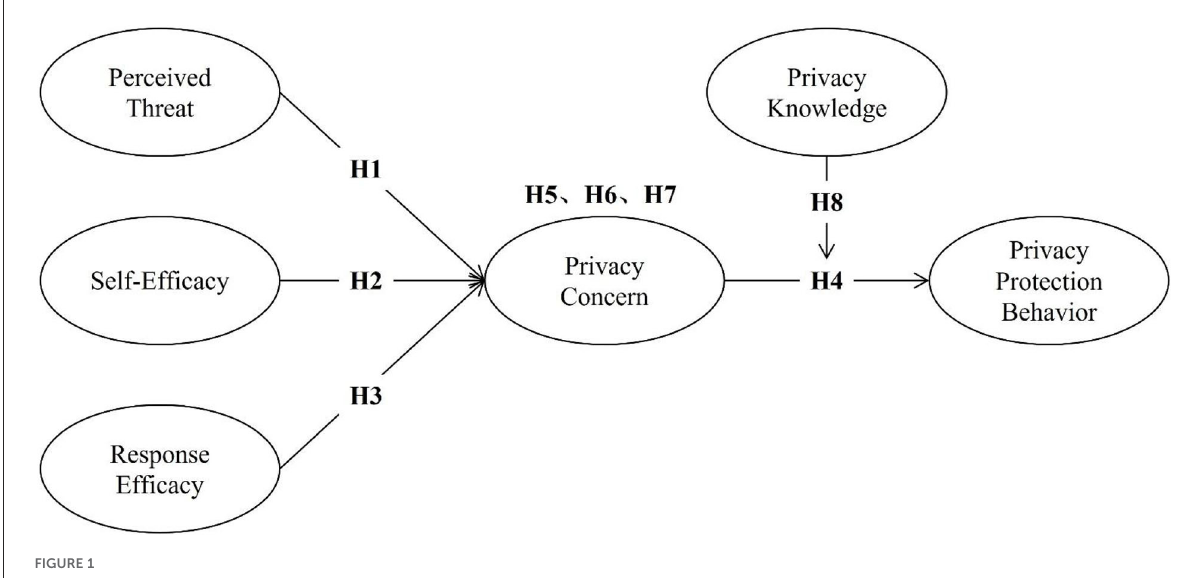
FIGURE1 The framework of the research model.